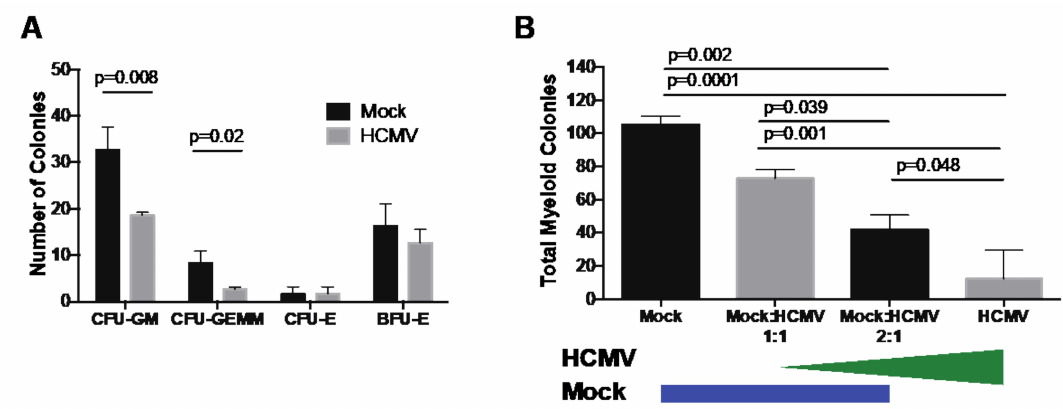
Figure 1. Human cytomegalovirus (HCMV) directly and indirectly suppresses myelopoiesis in vitro. CD34 + hematopoietic progenitor cells (HPCs) were infected with HCMV (TB40E / GFP) for 24–48 hrs. Infected cells were FACS-isolated for viable, CD34 + , GFP + HPCs. Uninfected cells were cultured in the same manner and sorted for viable CD34 + HPCs. ( A ) For analysis of the direct e ff ect of HCMV infection on myeloid di ff erentiation, sorted CD34 + (Mock) or CD34 + GFP + (HCMV) HPCs were plated at 500 cells per dish in Methocult H4434 and cultured for 14 days. Di ff erent myeloid (CFU-GM and CFU-GEMM) and erythroid (CFU-E and BFU-E) colonies were counted manually at 14 days post-plating. A representative experiment is shown in A. ( B ) For analysis of the indirect e ff ect of HCMV infection on myeloid di ff erentiation, sorted CD34 + (Mock) or CD34 + GFP + (HCMV) HPCs were plated at 500 cells per dish, or mixed at a ratio of 1:1 Mock:HCMV (500 Mock plus 500 HCMV), or at a ratio of 2:1 Mock:HCMV (500 Mock plus 250 HCMV), then plated in Methocult H4434. Total colonies were counted manually at 14 days post-plating. A representative experiment is shown in B. Error bars represent standard deviation for replicate dishes. Significance determined by unpaired t-test with Holm–Sidak correction for each colony type ( A ) or one-way ANOVA with Tukey correction ( B ), and p -values are listed for significant